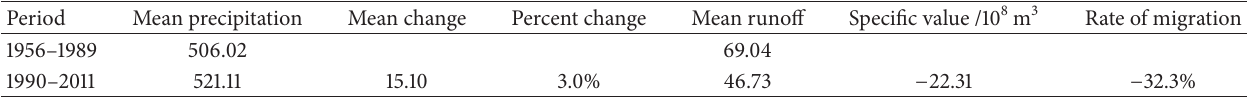
Period Mean precipitation Mean change Percent change Mean runoff Specific value /10 8 m